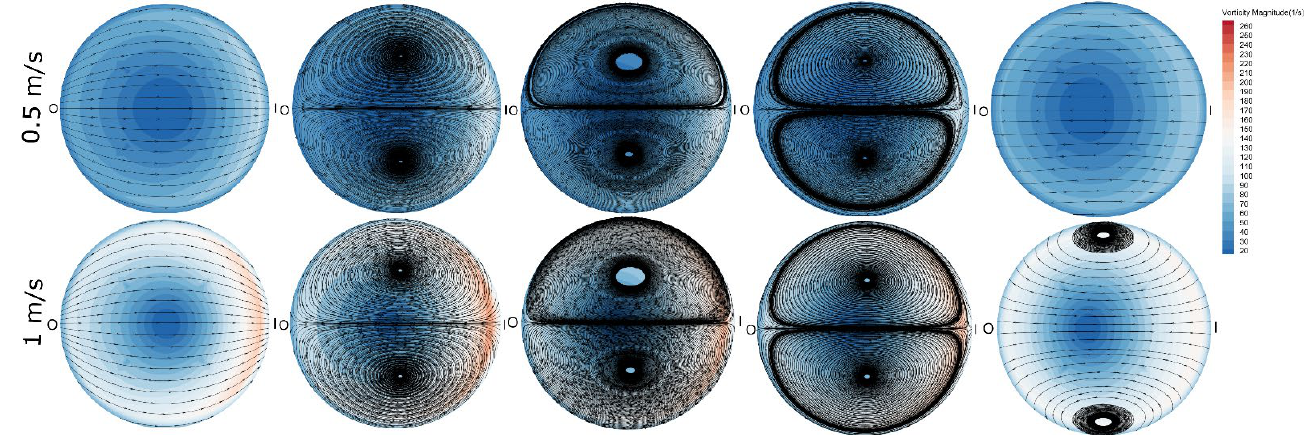
Figure 13. The vorticity magnitude and the projected streamlines at the five sections of the U-shaped channel. The upper row shows the data at the inlet velocity of 0.5 m/s at the temperature conditions of 283 K on the wall and 300 K of the incoming fluid at the inlet. The lower row shows the results at the inlet velocity of 1 m/s at the temperature conditions of 283 K on the wall and 300 K of the incoming fluid at the inlet.